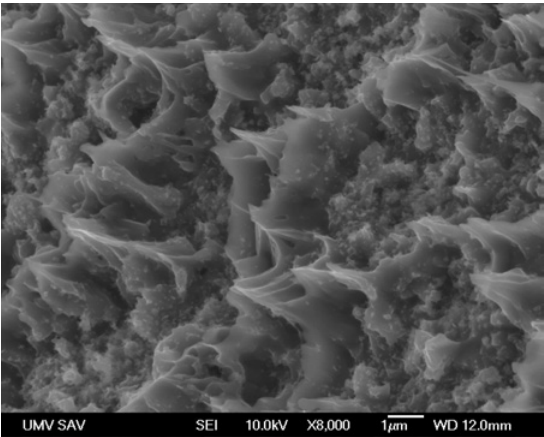
Figure 13. The fracture of Al-4 vol.% Al 4 C 3 after SP creep, direction 30°.